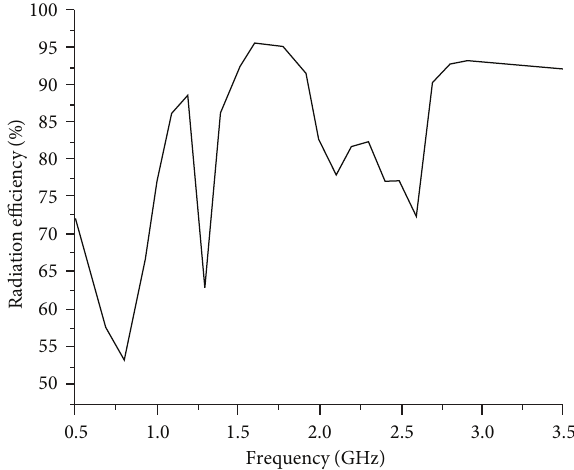
Figure 9: Simulated radiation efficiency of the proposed